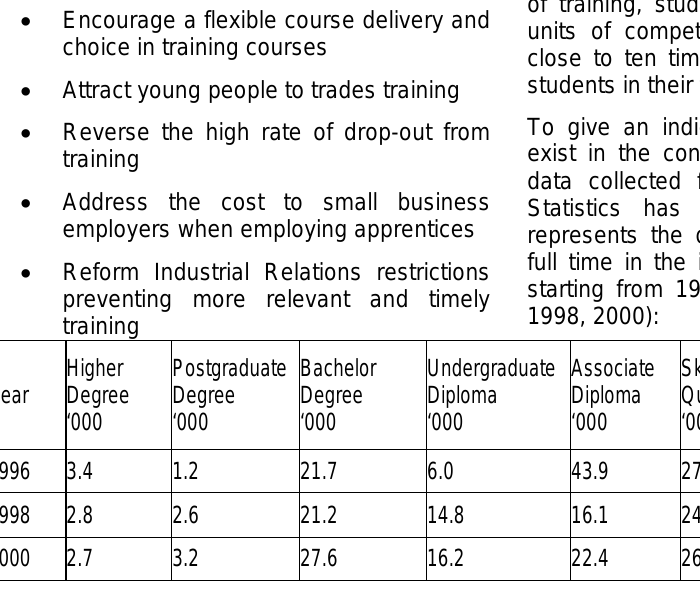
Table 2 (Australian Bureau of Statistics, pg. 14, 22, 1996, 1998, 2000) From the data shown in Table 2 there is a significant difference between the levels